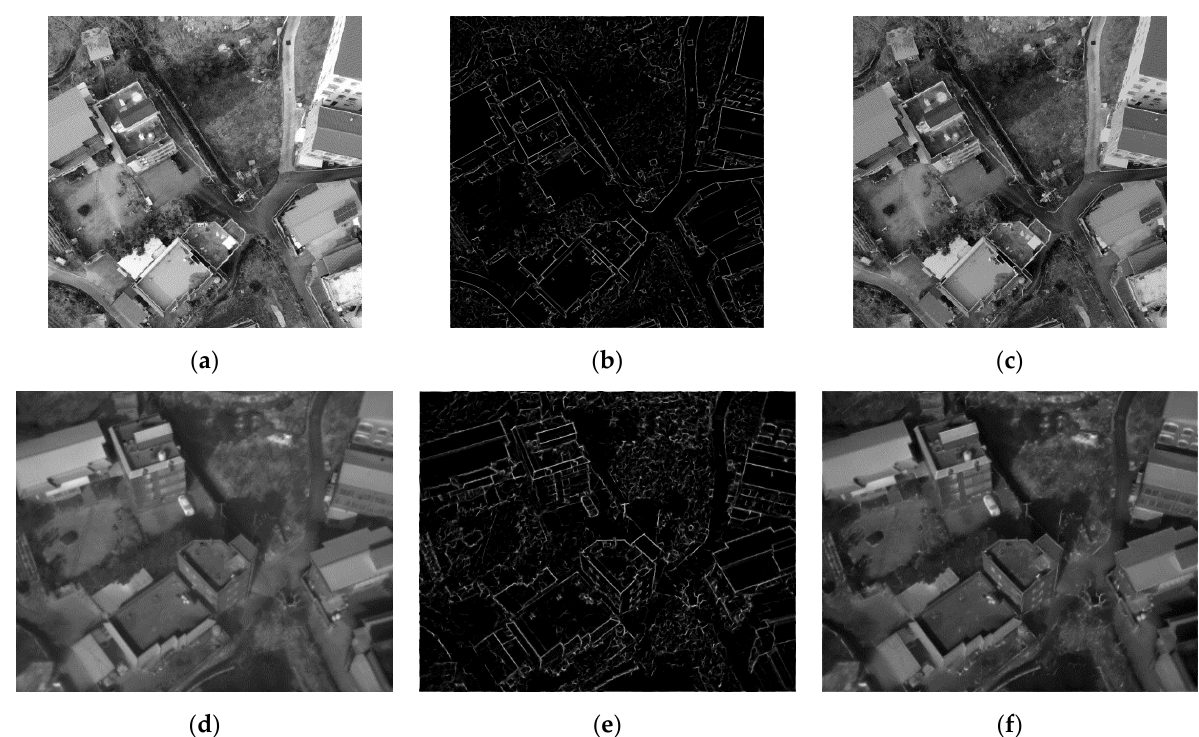
Figure 2. Generation of the combined image: ( a ) original visible image; ( b ) maximum moment of PC extracted from the visible image; ( c ) result of the combination of ( a , b ); ( d ) original TIR image; ( e ) maximum moment of PC extracted from the TIR image; ( f ) result of the combination of ( d , e ).